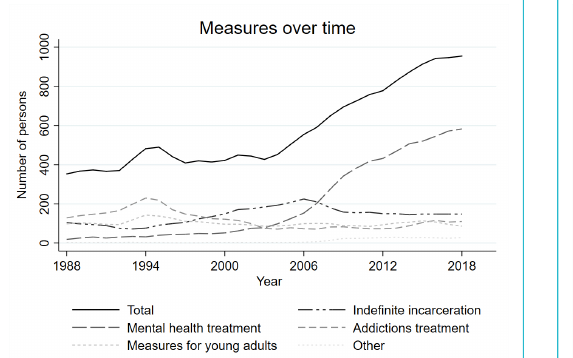
Figure S2: New admissions to and releases from custodial mea- sures over time in Switzerland. Only Swiss citizens are included.